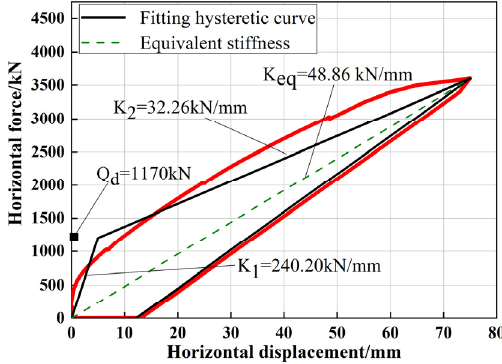
Figure 21. Hysteretic curve of isolation layer.